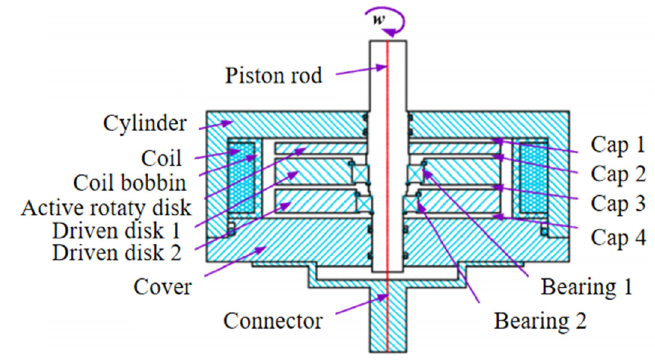
Figure 6. Compact rotating MRD with variable damping and stiffness [42].